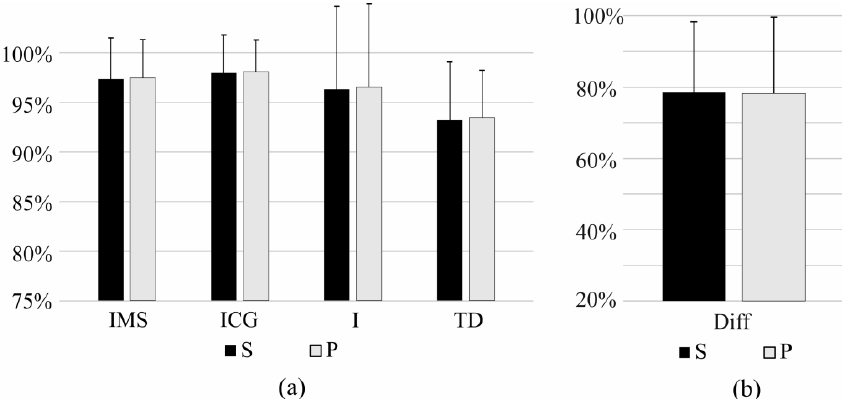
Figure 7. Sensitivity (S) and precision (P) of short-term identification of task and effort level using ( a ) IMS, ICG, I, and TD features, and ( b ) using Diff features. Results of the identification using Diff is showed in a different scale.